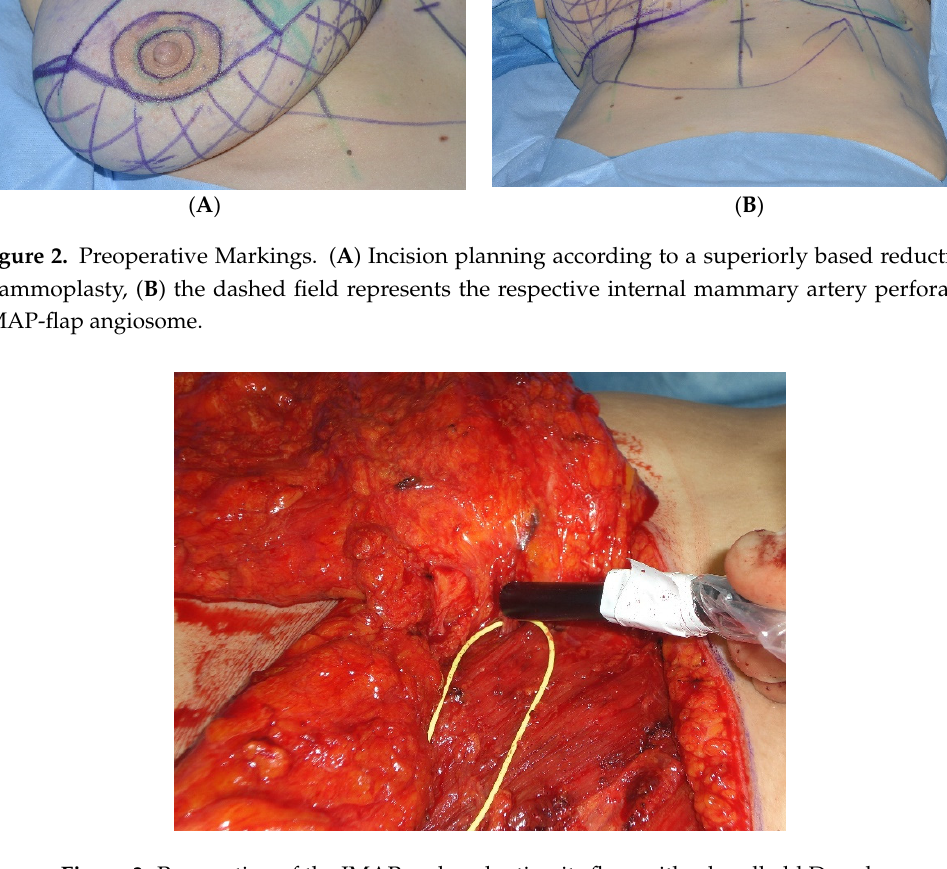
Figure 2. Preoperative Markings. ( A ) Incision planning according to a superiorly based reduction mammoplasty, ( B ) the dashed field represents the respective internal mammary artery perforator IMAP-flap angiosome.